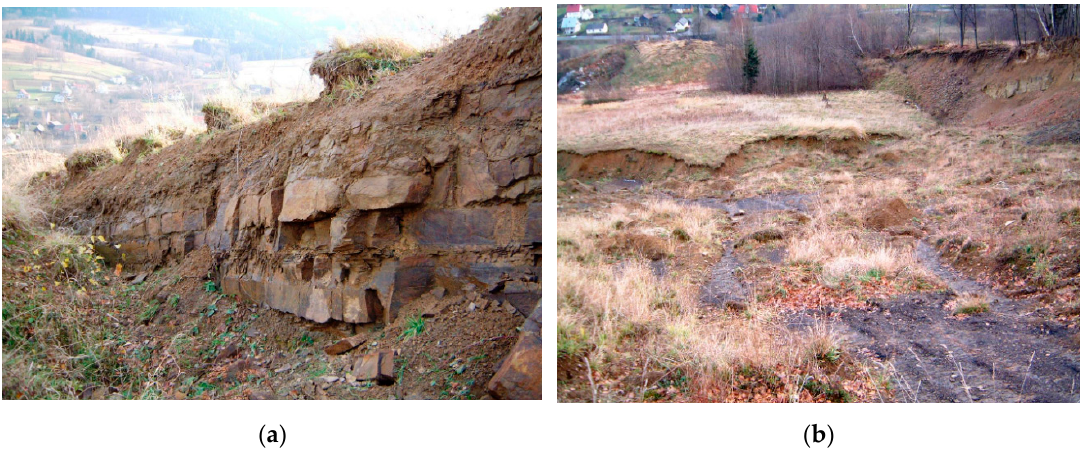
Figure 4. Example of the structure of a typical Carpathian flysch landslide (Stryszawa, Poland). ( a ) Rhythmical variables of flysch layers; ( b ) Opened sliding surface under the contact layer .